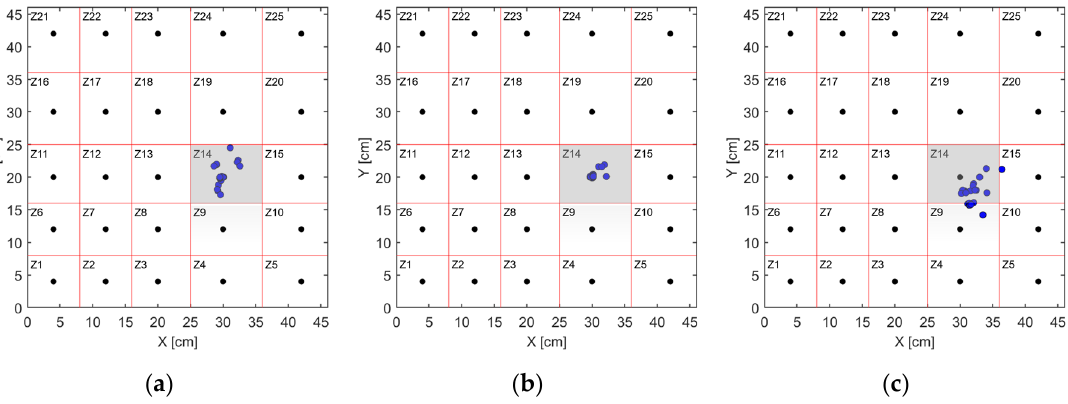
Figure 6. Localized sources estimated using the single-stage AIC method when the hit sources were far within the sensor network (or central region): when a hit was applied ( a ) on the raft top, ( b ) under the raft bottom, and ( c ) at the middle of Pile #14. In ( c ), the middle of the pile at a distance 10 cm down from the top of the raft was struck.